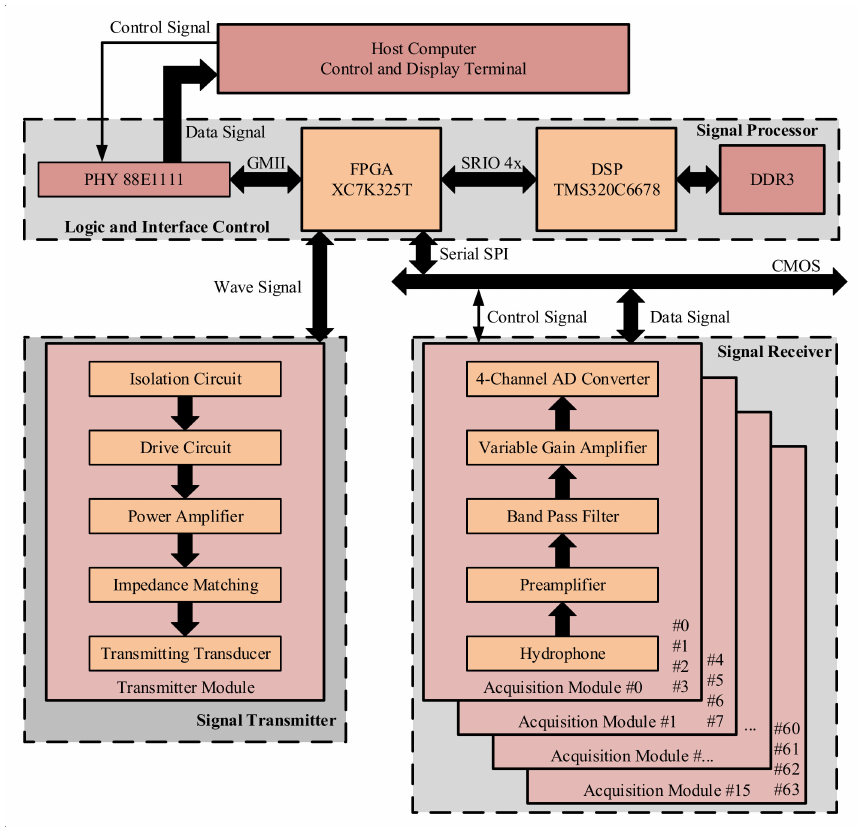
Figure 4. System hardware block